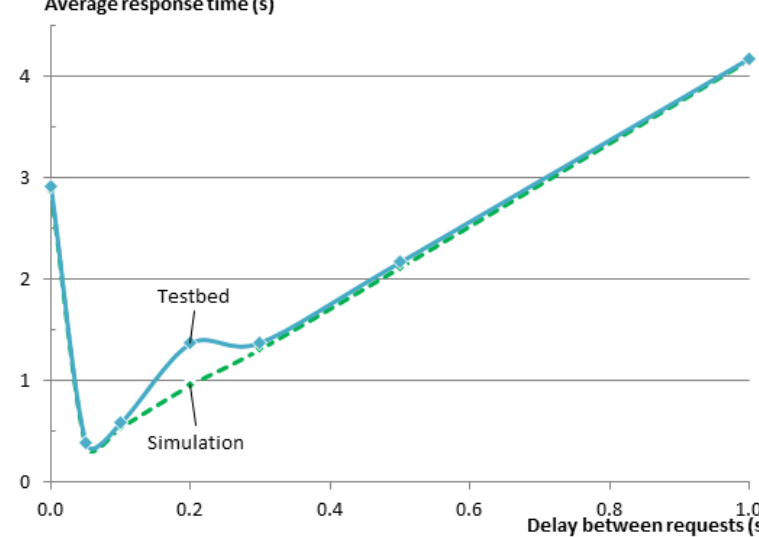
Figure 7. Response time of an entity with five members as a function of the delay between individual requests, evaluated using both a simulator and the experimental